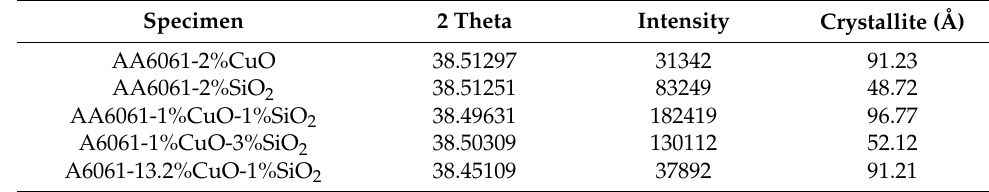
Table 15. Crystallite size of samples at peak